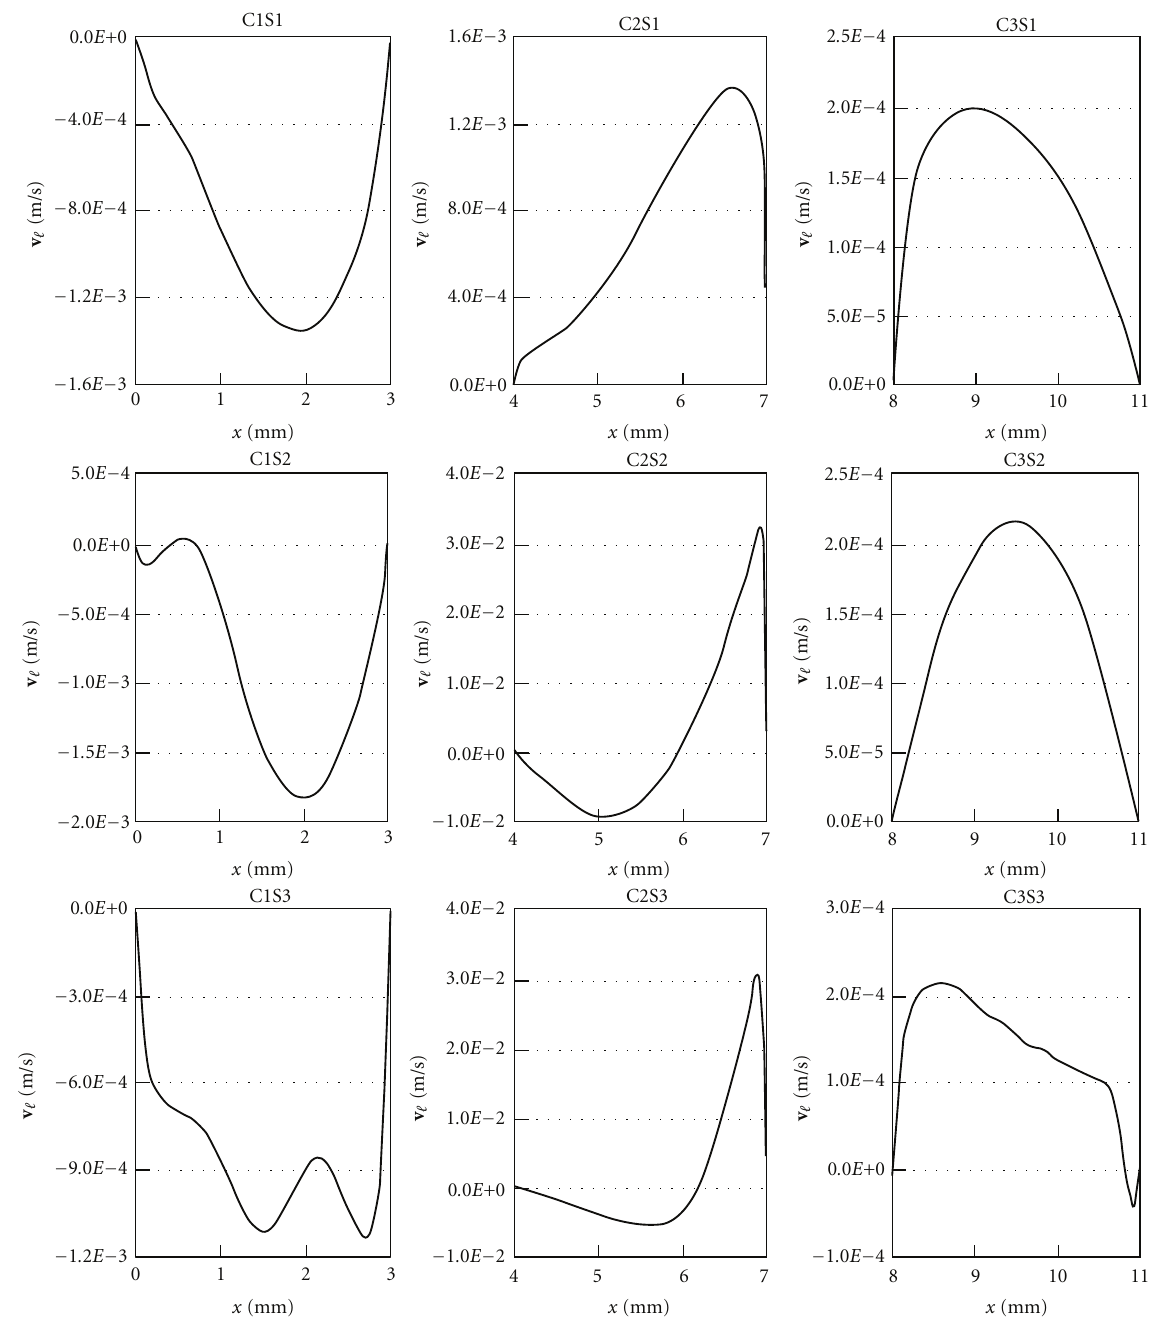
Figure 5: Time-averaged profiles of the vertical liquid velocity at various location of Geometry 2.